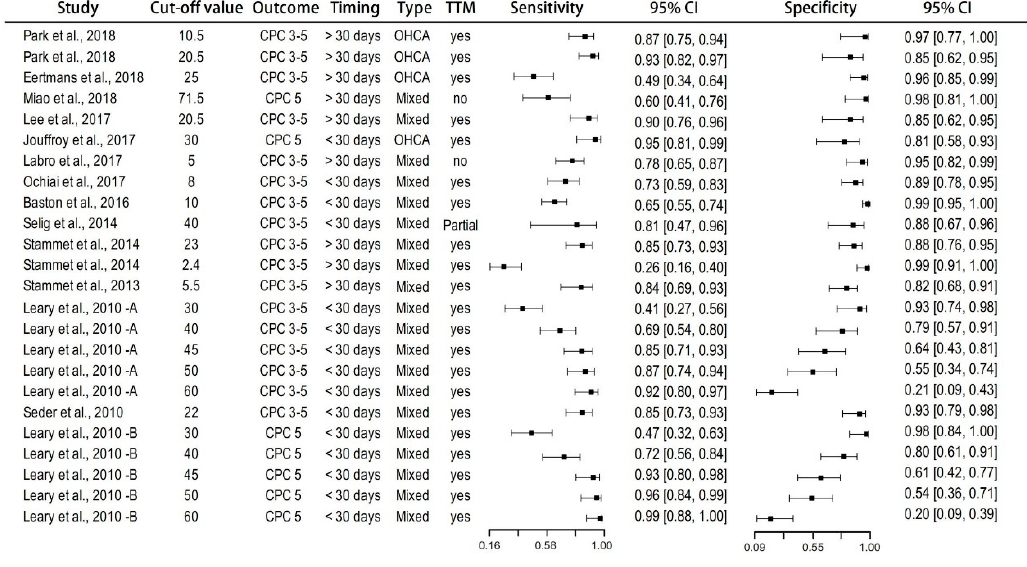
Figure 3. Sensitivity and specificity of the included studies.